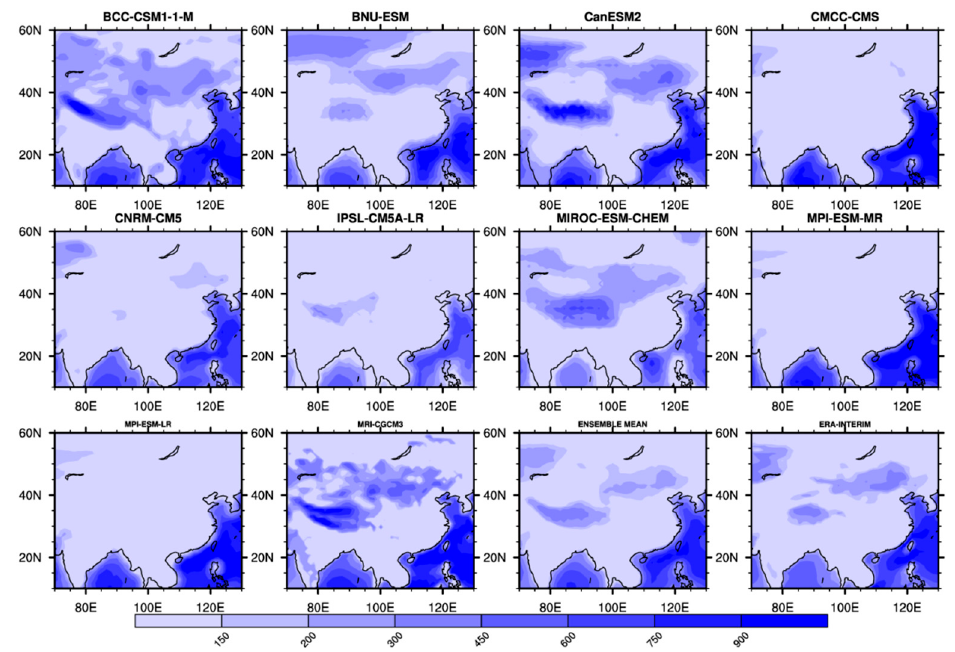
Figure A2. Spatial distribution of mean wind power density (WPD) in W / m 2 based on 90 m above ground level extrapolated wind speed for the current period of 1981–2005 for the CMIP5 models, their ensemble mean, and ERA-Interim.